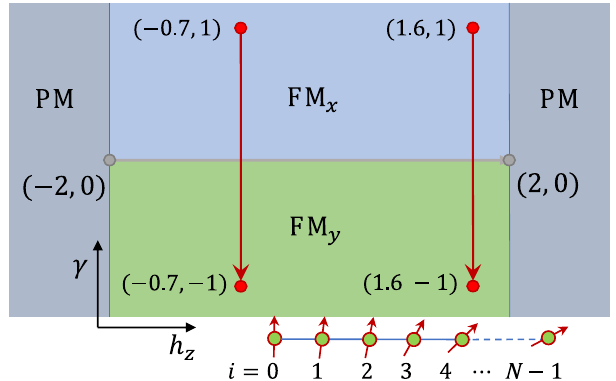
FIG. 3. Phase diagram of LSM model as a function of ( h z , γ ) and the quench protocol. Two ferromagnetic phases (FM FM y ) and a paramagnetic phase are present in the ground-state phase diagram of the LSM model in the thermodynamic limit ( N → ∞ ). The phase boundaries and tricritical points are also shown. Below we present results of AVQDS simulations for the two vertical parameter paths indicated here, which quenches the system from the FM x to the FM y phase at finite speed, together with postquench